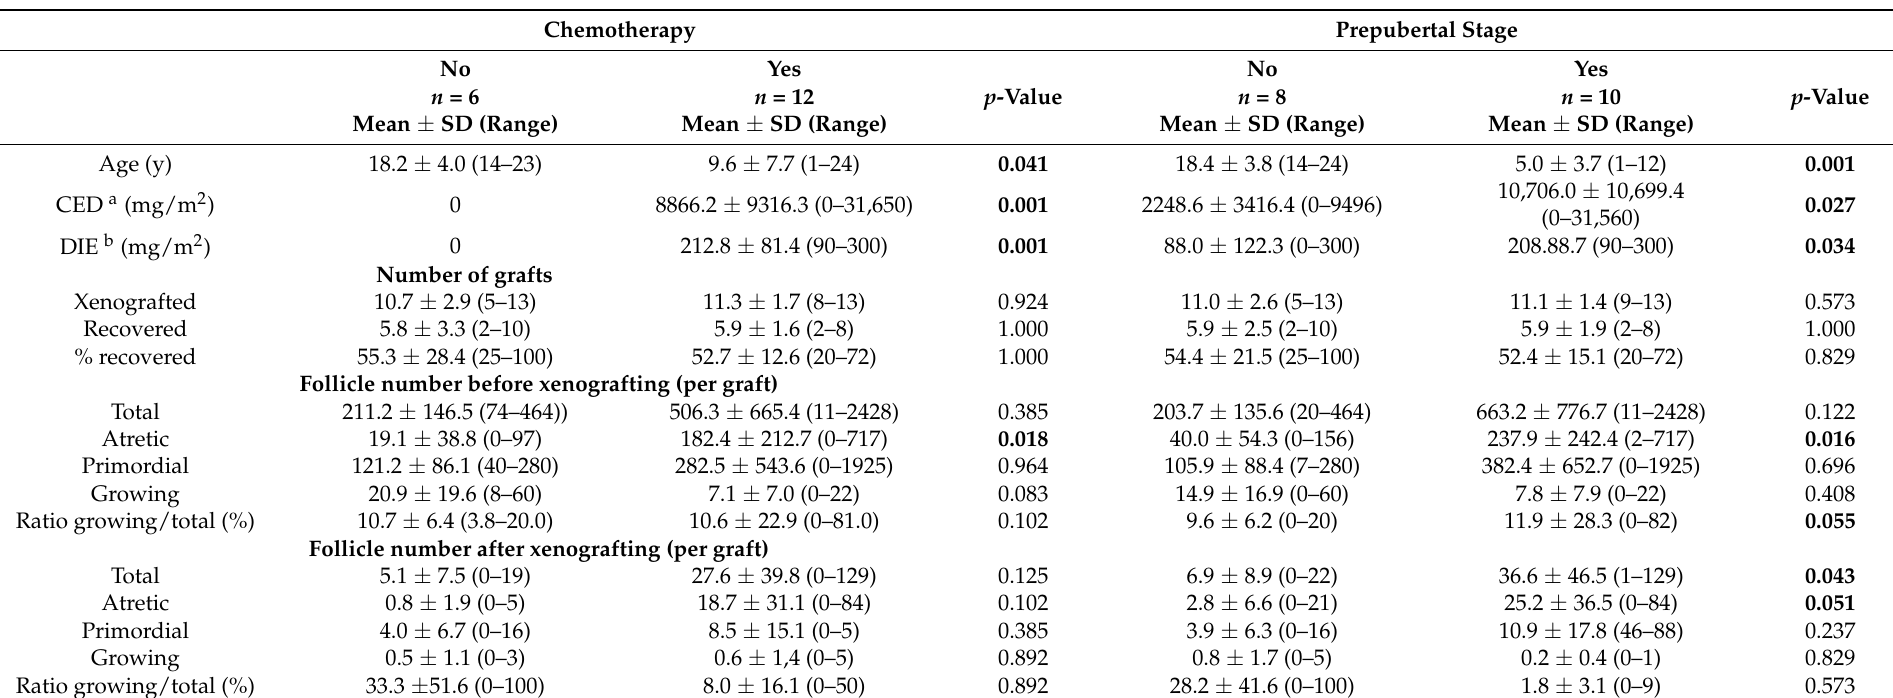
Table 2. Mean, standard deviation (SD) and range of follicle numbers per graft of cryopreserved human ovarian tissue before and after xenografting by prepubertal stage and previous